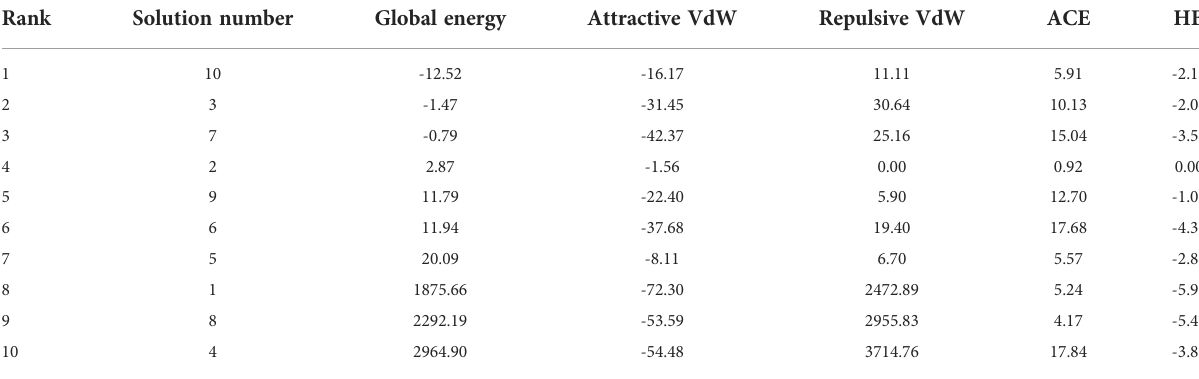
TABLE 3 Docking score of re fi ned complexes of TLR-4 and